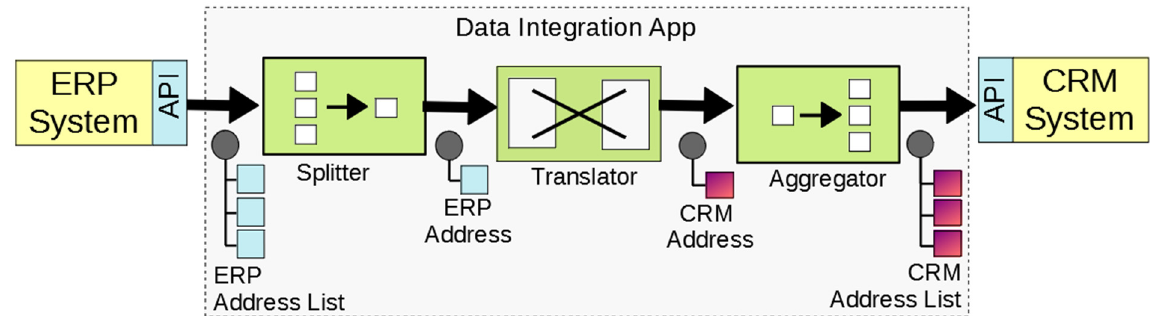
Figure 4. EIP Translator (on the basis of [14] (p. 86)).